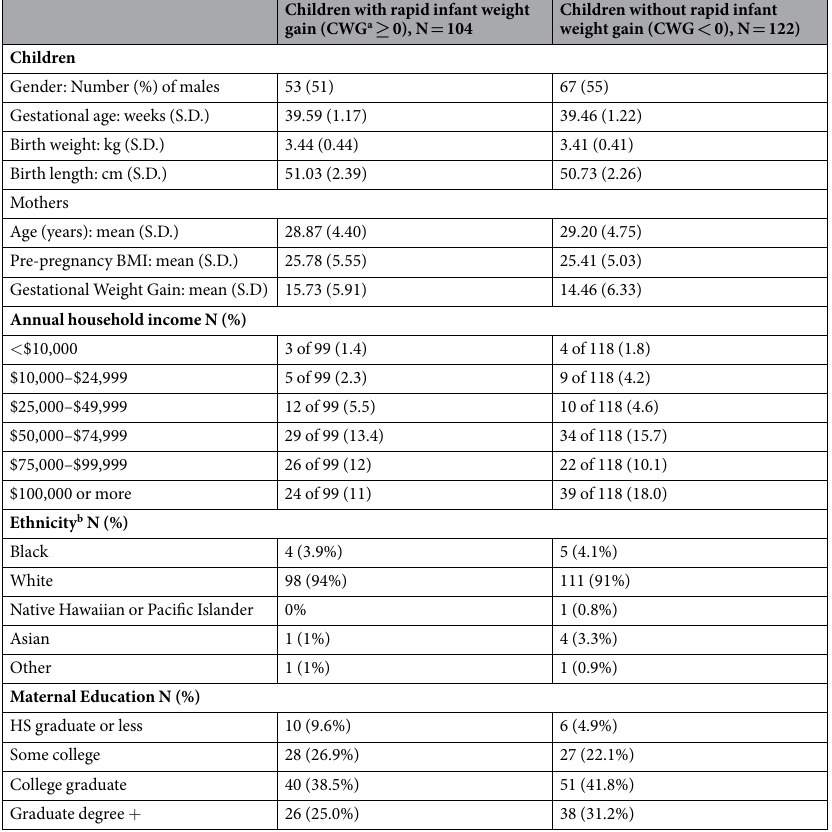
proportion of Bacteroidetes (p = 1.1 × 10 − 14 ), Firmicutes (p = 2.9 × 10 − 3 ), Proteobacteria (p = 8.7 × 10 − 6 ), and Verrucomicrobia (p = 2.0 × 10 − 5 ) between the child gut microbiota and the mother oral microbiota. Additionally, there were significantly different proportions of Bacteroidetes (p = 2.2 × 10 − 6 ), Proteobacteria (p = 7.1 × 10 − 6 ), and Verrucomicrobia (p = 2.2 × 10 − 5 ) between child gut microbiota and child oral microbiota. However, no sig- nificant differences in the proportions of any bacterial phyla were observed between maternal and child oral sam- ples. Using non-metric multidimensional scaling (NMDS) to visualize the distances among the three microbiota types (Supplementary Fig. S2B), we found that there was some overlap between oral and gut microbiota commu- nities, but gut samples largely clustered together and away from oral samples (mother and child), and children’s oral samples formed a tighter cluster than maternal oral samples. These results corroborate the significant differ- ences in proportions between child gut/mother oral and child gut/child oral microbiotas. Growth curves and their relationship with the microbiota. Since the outcome measurement recom- mended by American Academy of Pediatricians for children under two years of age is weight-for-length 59 , growth curves were constructed based on this ratio (later called growth index ) measured at seven time points during the first two years after birth (see Methods). This set of longitudinal observations (Fig. 1a and Supplementary Fig. S3) was then processed with FDA techniques 60 : the growth indexes of all children were pooled to estimate population-level curve parameters (mean and covariance functions), and smooth individual growth curves were constructed forming best linear unbiased predictors of the missing segments (see Methods). These curves were monotonously increasing (Supplementary Fig. S3B), highlighting fast growth rate over the first two years after birth. Because each child may hit growth spurts at a slightly different age 20 , we aligned the curves based on their dominant shapes (Fig. 1b). The alignment procedure had only minor effects on the curves (compare Supplementary Fig. S3B and Fig. 1b) but allowed us to focus on variation in the amplitude of the curves (i.e. growth index on the vertical axis), while reducing variation in their temporal phasing (i.e. time on the horizontal axis). The functional regressions we utilized in this study can be thought of as a more general, non-parametric alternative to a mixed effect model − which captures the longitudinal nature of the data, and in fact does so with- out making specific assumptions on the form of the mean relationship, and of the intraindividual dependence structure of the observations. This approach is more general and can be more effective than classic multivariate mixed model analyses when the data exhibit complex temporal dynamics 61 . To evaluate associations between children’s weight gain and the microbiota information, we started by applying FDA regression techniques (see Methods). Using children’s growth curves (Fig. 1b) as the response